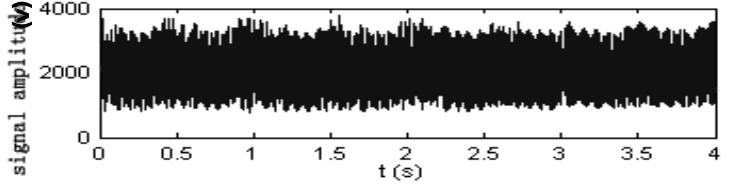
Figure 4. Audio signal of intermediate frequency power supply.